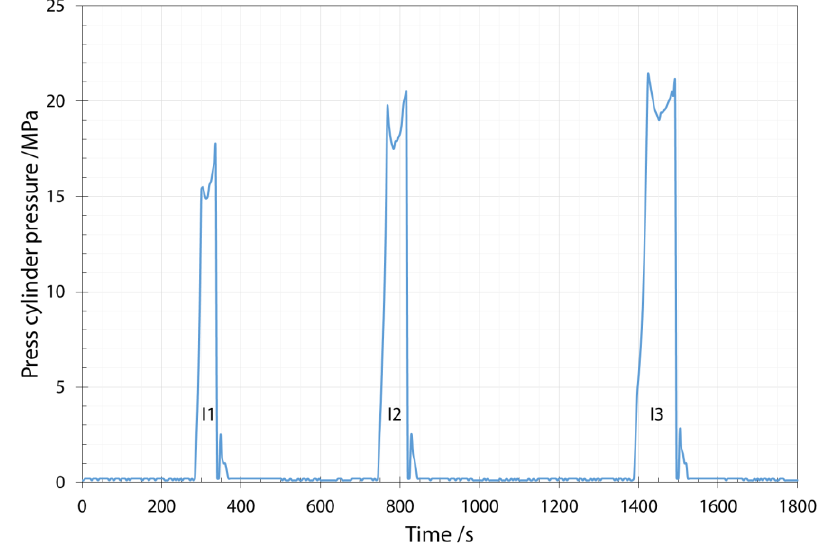
Figure 6. Main cylinder pressure for all billets extruded with indirect-extrusion press (details listed in Table 3).